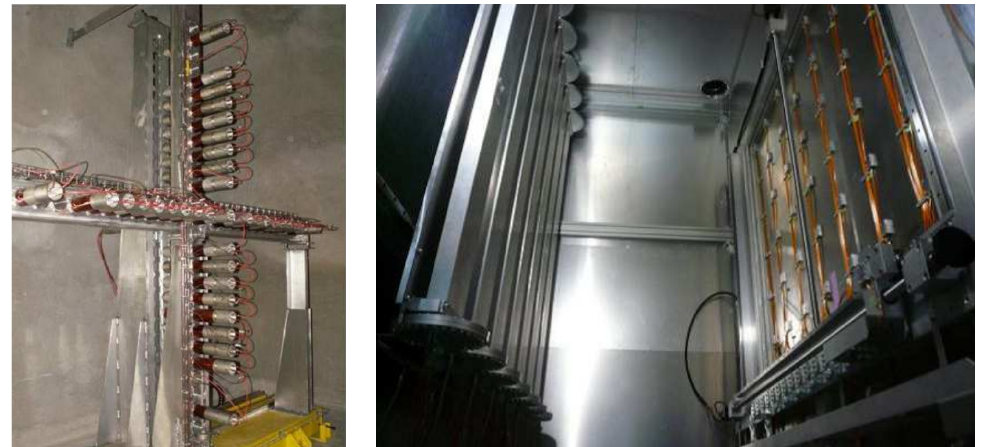
Figure 13. Muon monitoring detectors employed for the CNGS neutrino beam ( left ) and the J-PARC beam ( right ). The CNGS chambers consisted of 42 muon detectors separated by 11.25 cm and spanning a length of 2.7 m. The J-PARC system (MUMON) is composed of 7 7 ionization chambers × (left side of the picture) and 7 7, 1 cm 2 , PIN photodiodes (right side). The beam enters from the × right side. Reproduced under CCA4.0-I license with permission from Sissa-Medialab